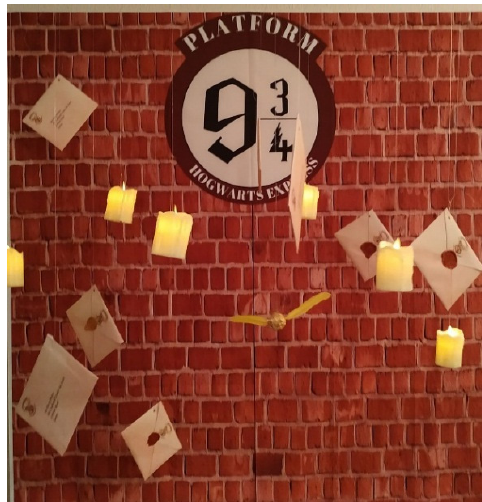
Figure 1. Letter of admission .